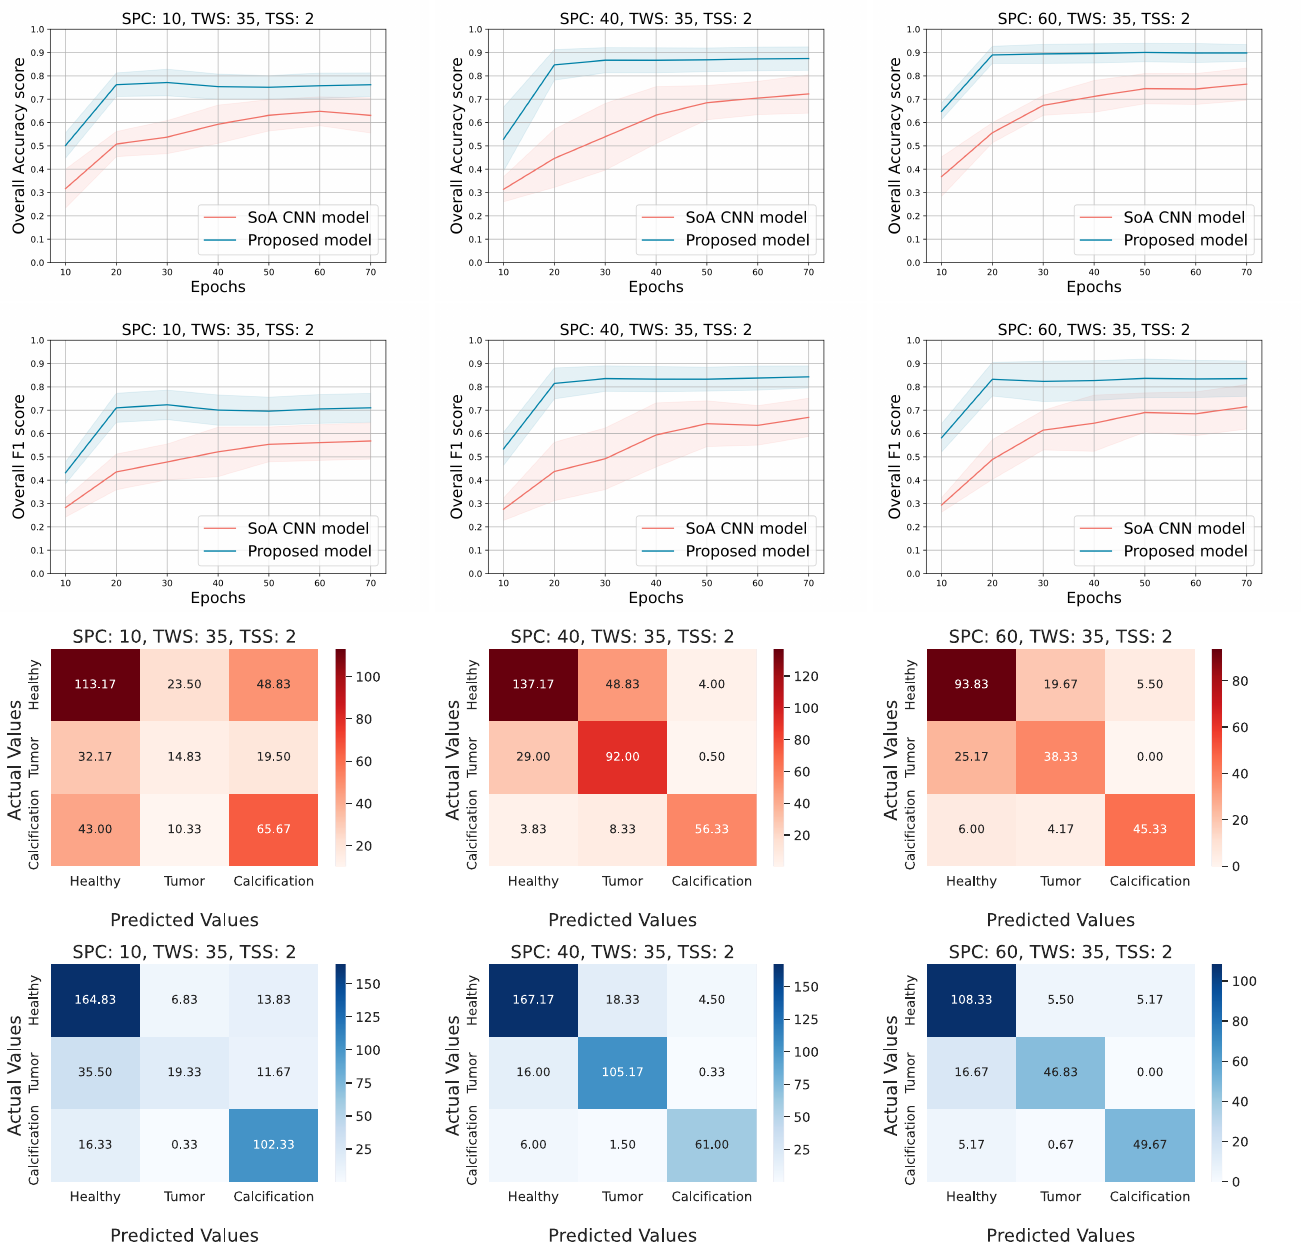
Figure 5. Experimental results for the following configuration; TWS = 35, SPC = (10, 40, and 60) and TSS = 2. The overall accuracy and F1 score on the testing set are presented in the first two rows, respectively. The rest of the rows correspond to the confusion matrices of the AlexNet (red hues) and the tensor-based approach (blue hues)